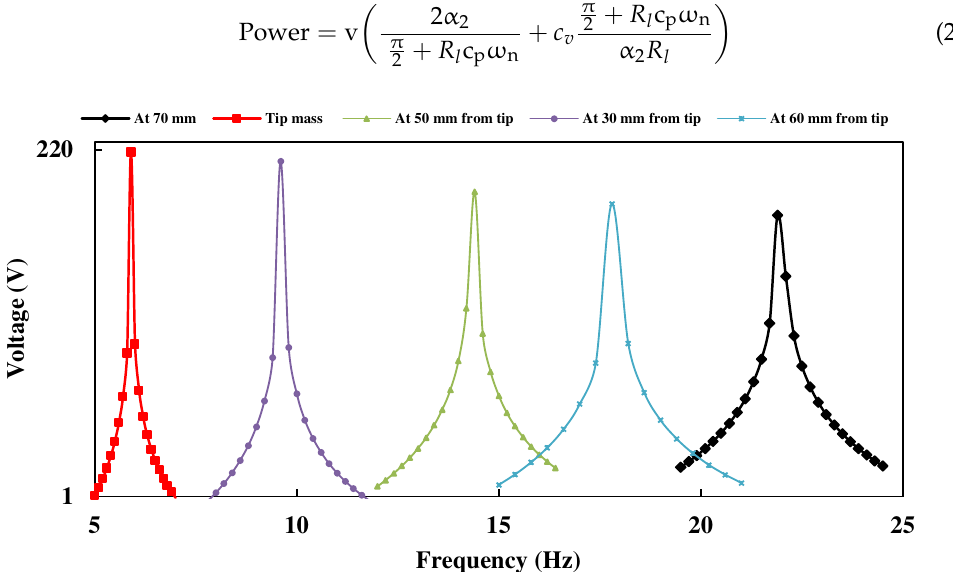
Figure 14. The voltage of the harvester at different frequencies.